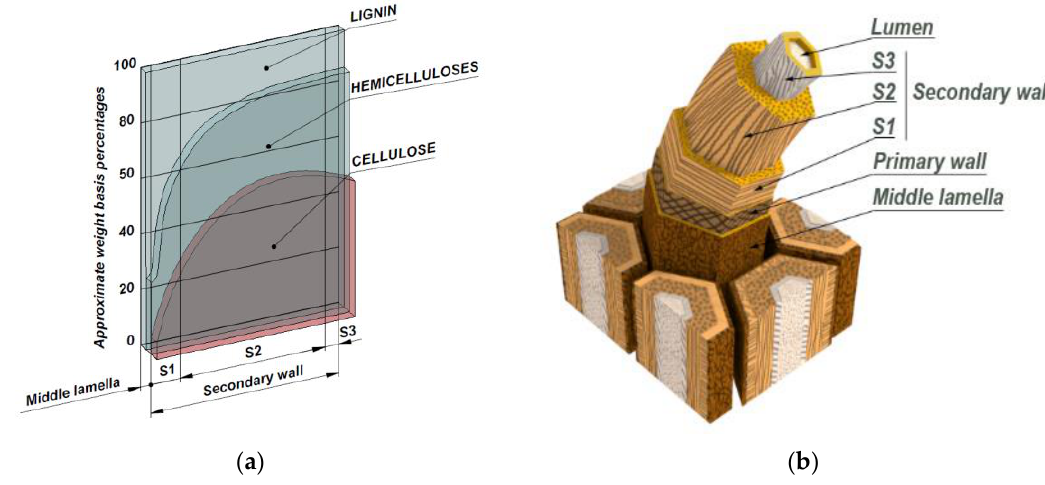
Figure 1. Chemical composition and structure of a typical lignocellulosic fiber: ( a ) Evolution of the chemical composition against depth; ( b ) Standard structure of a wood fiber.